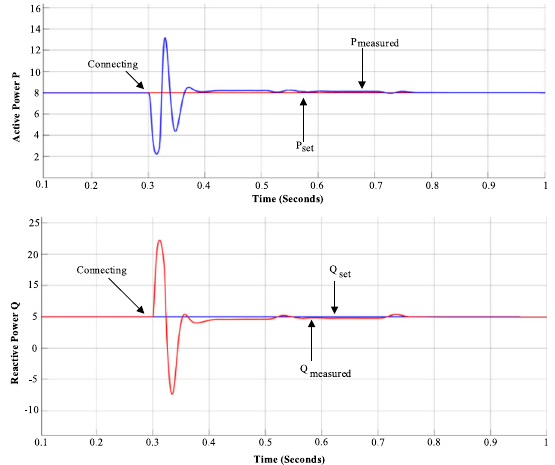
Fig. 9 Tracking output power of PQ control